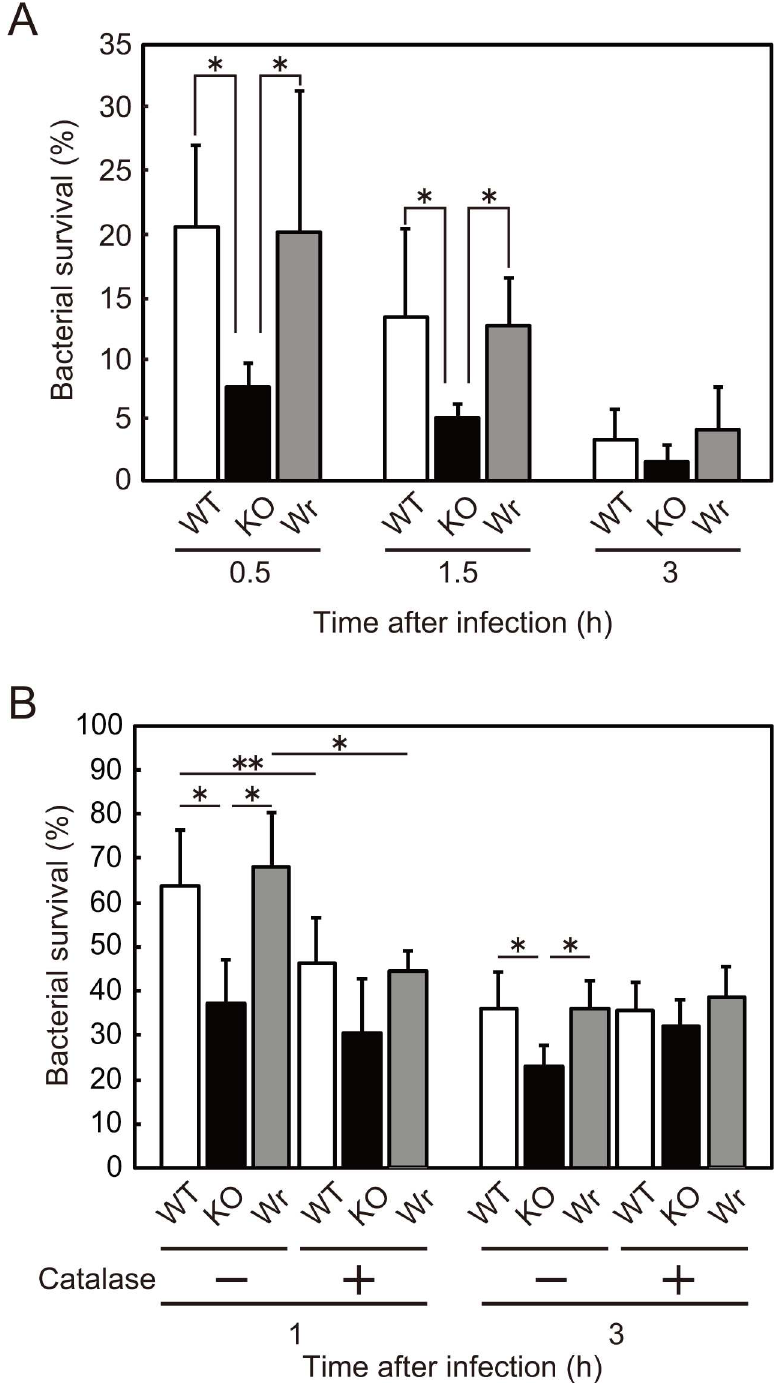
Fig 2. Bactericidal tests with S . sanguinis strains. (A) Human whole blood (180 μ l) was mixed with the WT, KO, or Wr strain (1x10 5 CFU). Followingincubationfor 0.5–3 h at 37˚C, each mixture was seeded onto TH agar plates. Grown colonieswere countedand the survival rate of each S . sanguinis strain is shown as % inoculum.Data are presentedas the mean ± SD of triplicate samples from 3 independentexperiments. Statistically significantdifferences were evaluatedusing one-wayANOVA and Tukey’s multiplecomparison test. * p < 0.01, ** p < 0.05.(B) Neutrophils were incubatedwith the S . sanguinis strains at an MOI of 10 with or without catalase(100 units/ml). Followingincubationfor 1 or 3 h at 37˚C, each mixture was plated on TH agar plates. The survival rate of S . sanguinis is shown as % inoculum.Data are presentedas the mean ± SD